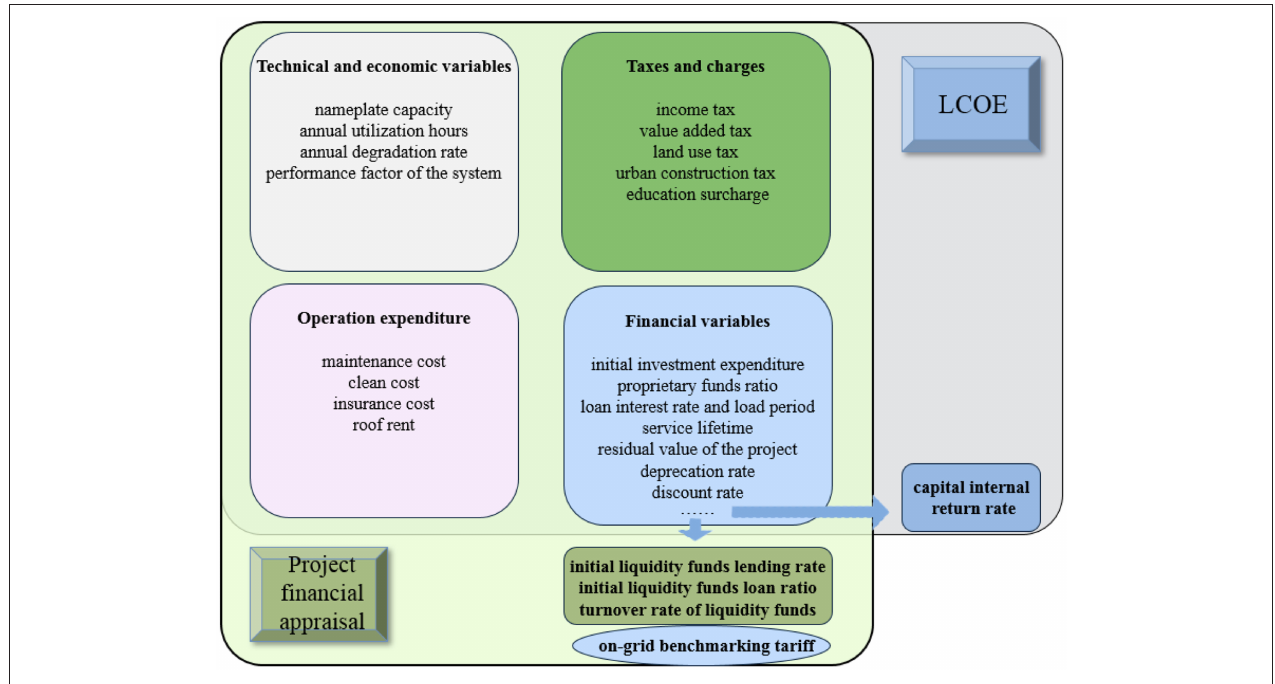
FIGURE 4 | Model variables and